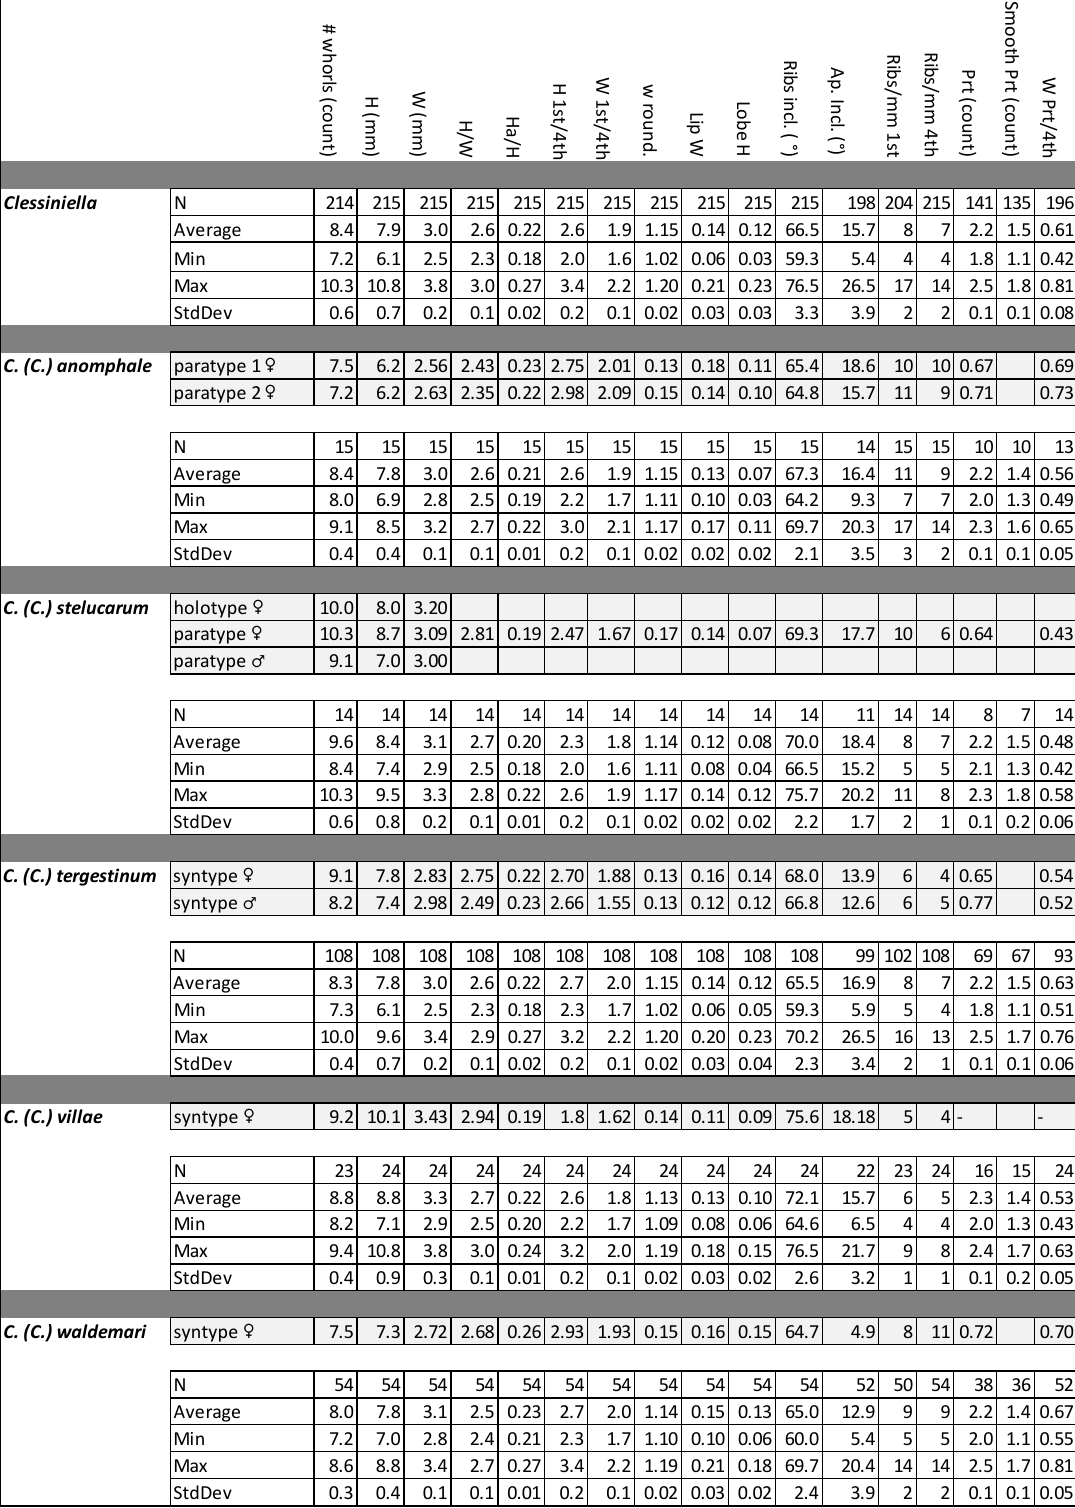
Table 2. Shell measurements. Abbreviation: N = number of female specimens